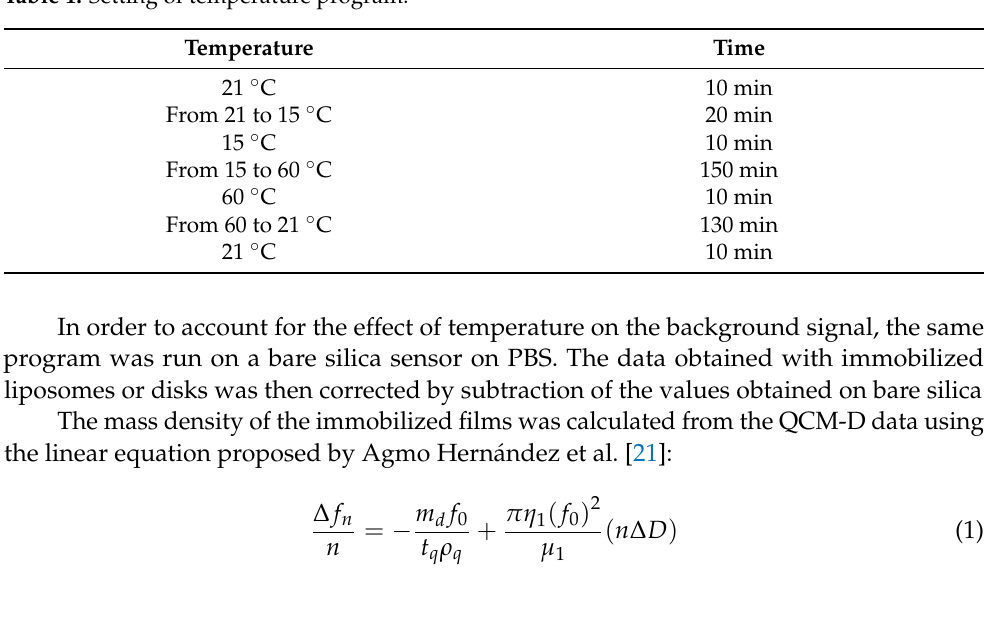
Table 1. Setting of temperature